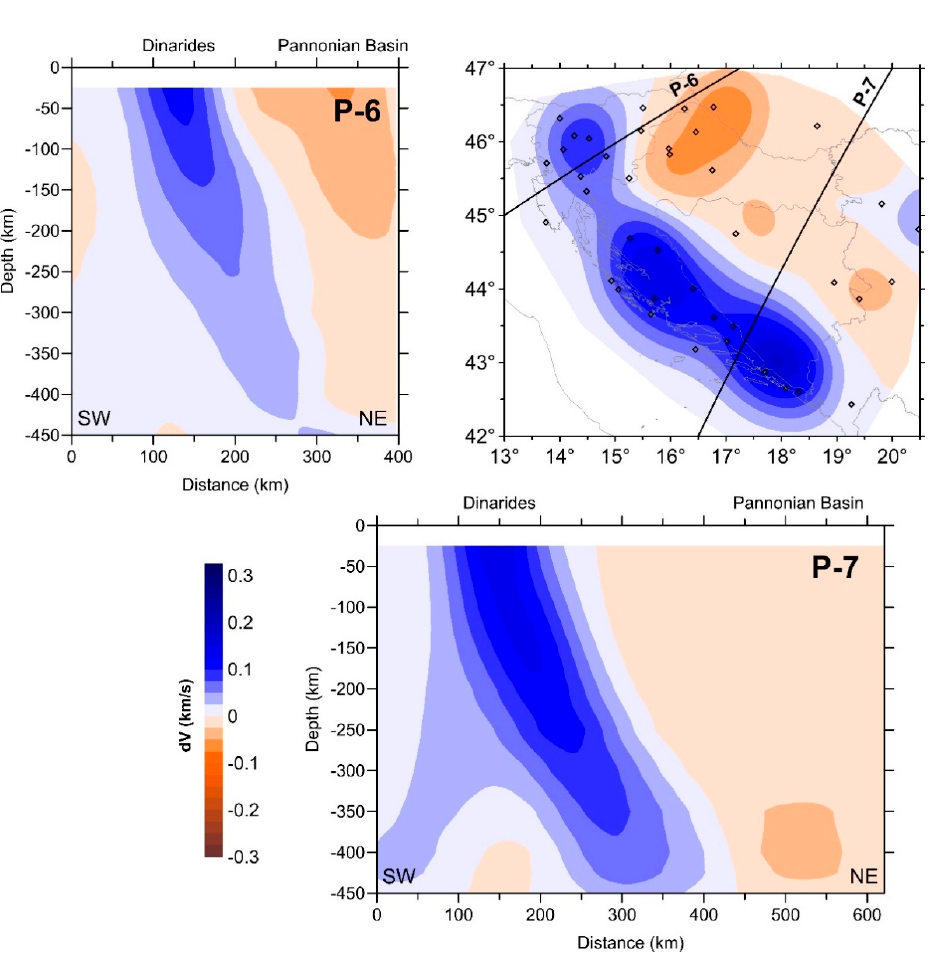
Figure 4. Depth slice at 100 km using the three-dimensional velocity SU-model [8]. Pronounced fast anomaly can be followed in the entire Dinaridic mountain belt. Diagonal cross-sections placed in the Northern and Southern Dinarides (P-6 and P-7) point out the steep fast anomaly beneath the Dinarides probably caused by the descent Adriatic lithospheric slab. Damping of the fast anomaly in the Northern Dinarides is seen on the depth